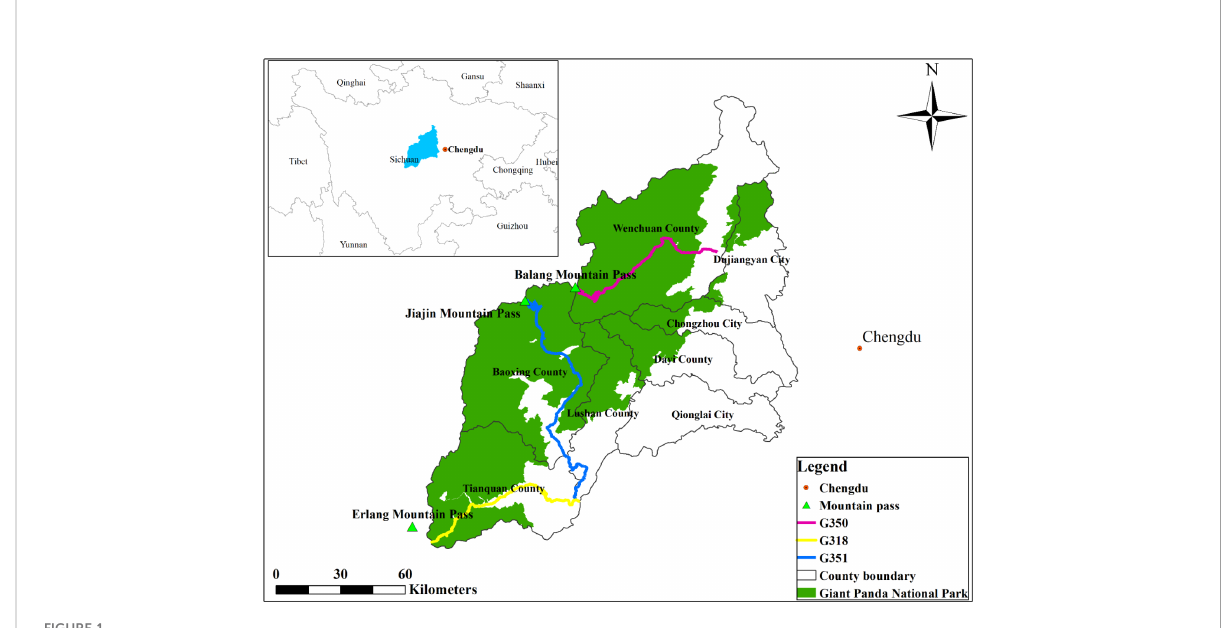
FIGURE 1 Locations of three major roads in the Qionglai mountain